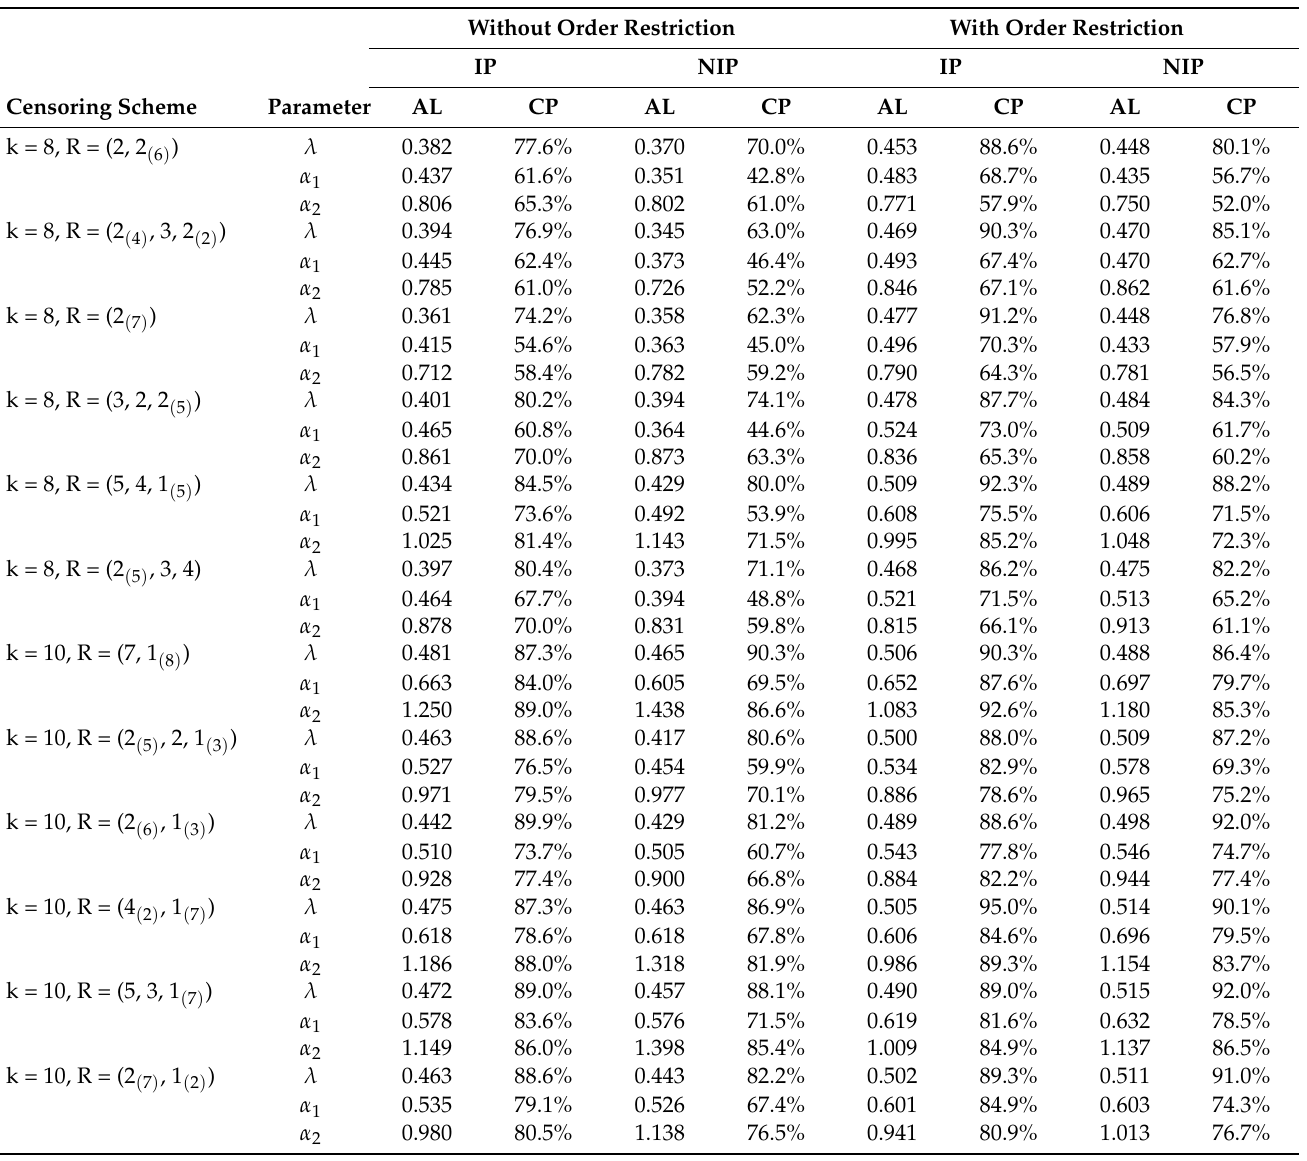
Table 7. CPs and ALs of 95% HPD credible interval of the model parameters with λ = 0.5, α 1 = 0.4, and α 2 = 0.8 based on different CSs. Without Order Restriction With Order